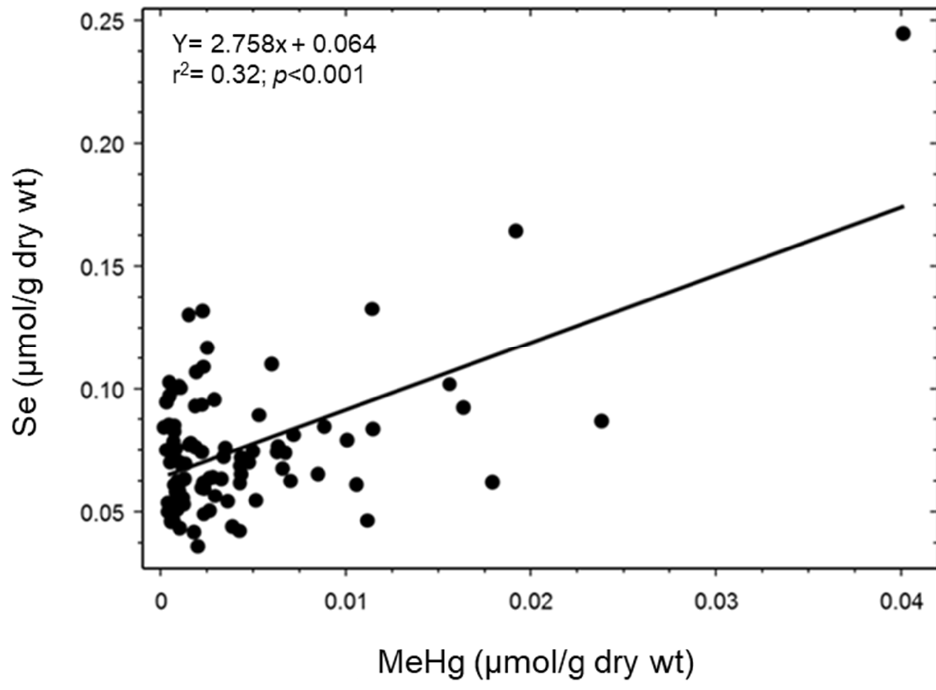
Figure 1. Relation between the concentrations of total selenium (Se) and methylmercury (MeHg) in livers of northern pike (F 1,92 = 42.48; p < 0.001; r 2 = 0.32; n = 94).